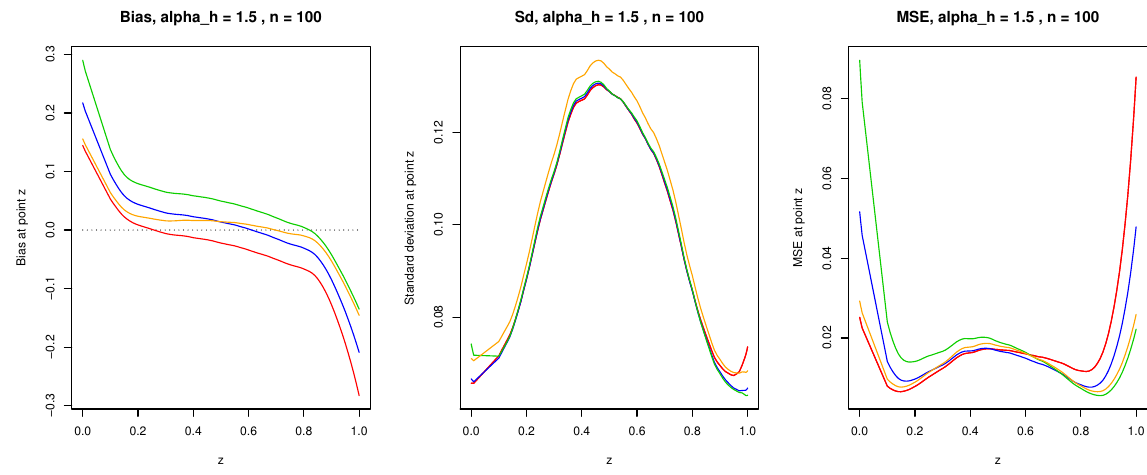
Figure 1: Local bias, standard deviation and MSE for the estimators ˆ τ (1) (red) , ˆ τ (2) (blue), ˆ τ (3) (green), ˜ τ (orange), with n = 100 and α h = 1.5 in Setting 1. The dotted line on the first figure is the reference at 0.